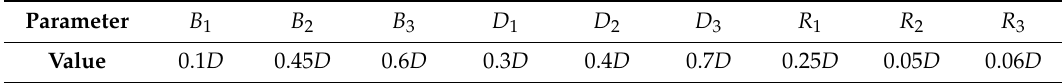
Table 2. Conversion scale of each parameter.